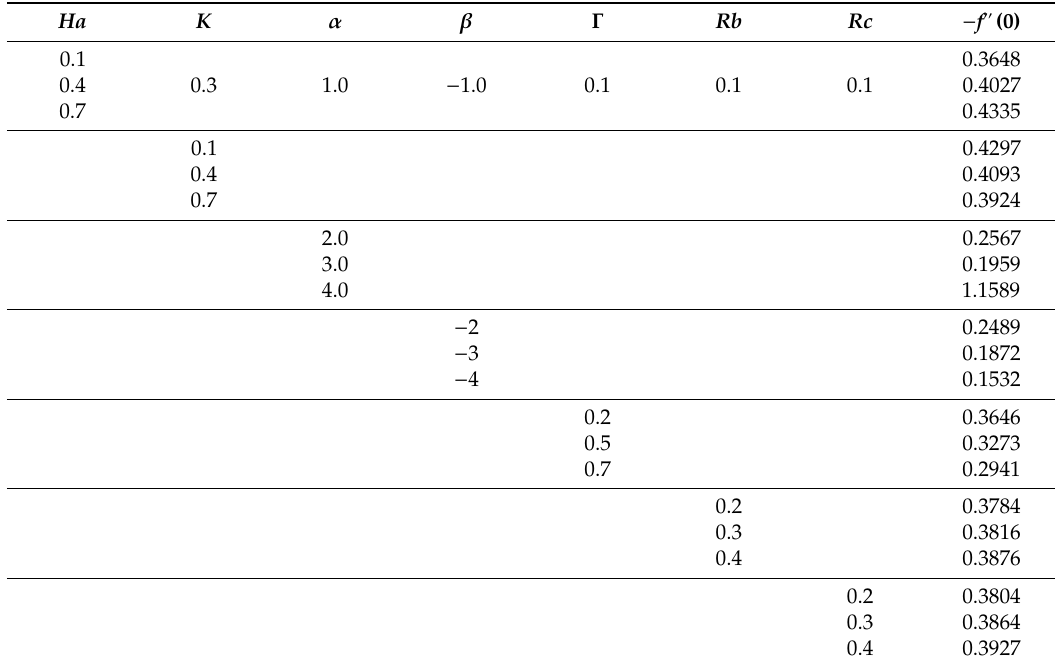
Table 2. Variation of skin friction coe ffi cient − f (cid:48)(cid:48) ( 0 ) for Ha , K , α , β , Γ , Rb and Rc .